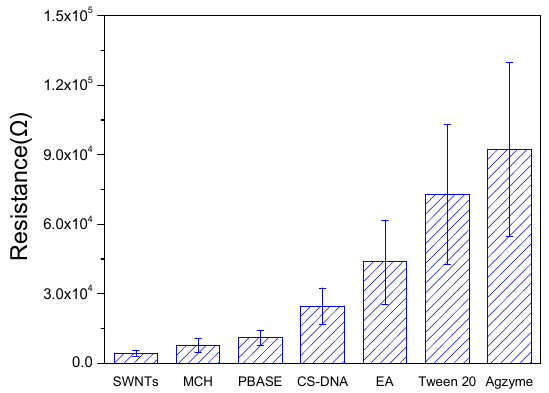
Figure 3. Changes in resistance after FET functionalized with different materials (SWNTs, MCH, PBASE, CS-DNA, EA, TWEEN20, and Agzyme) at V DS = −0.02 V.